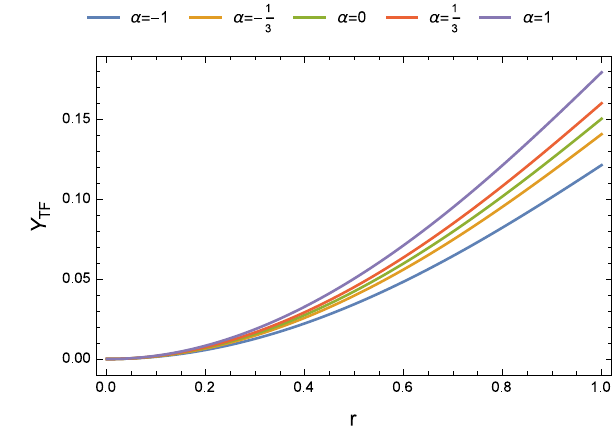
Fig. 1 Y TF vs the radial coordinate r for K = − 2 and varying α Fig. 2 Y